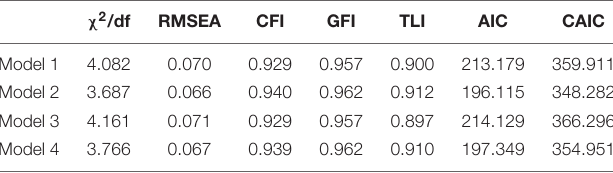
TABLE 3 | Fit indices of competing models 1, 2, 3, and